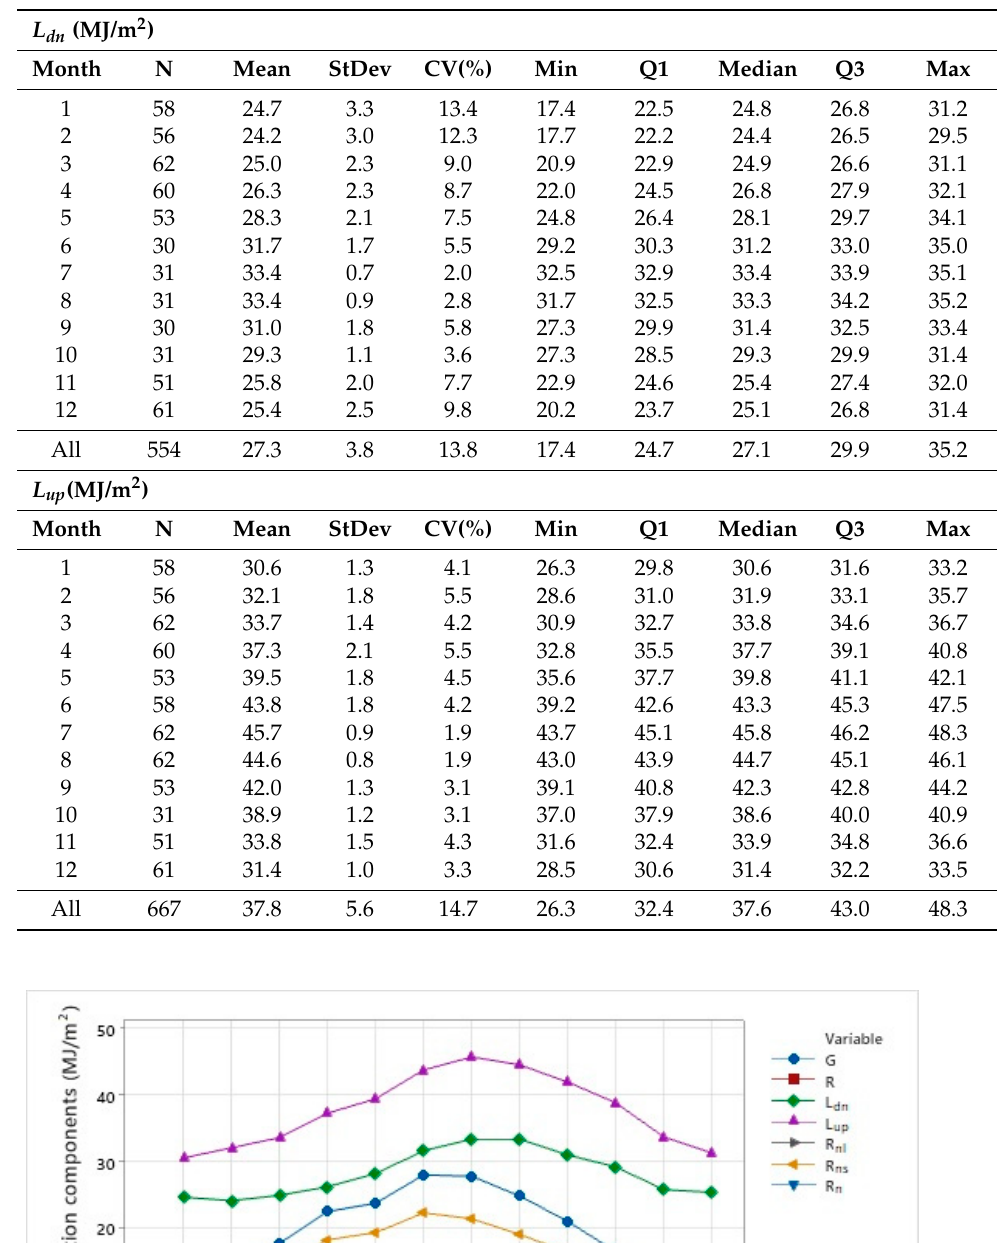
Table 5. Statistics of daily downward and upward longwave irradiation (MJ m − 2 ) at Athalassa.